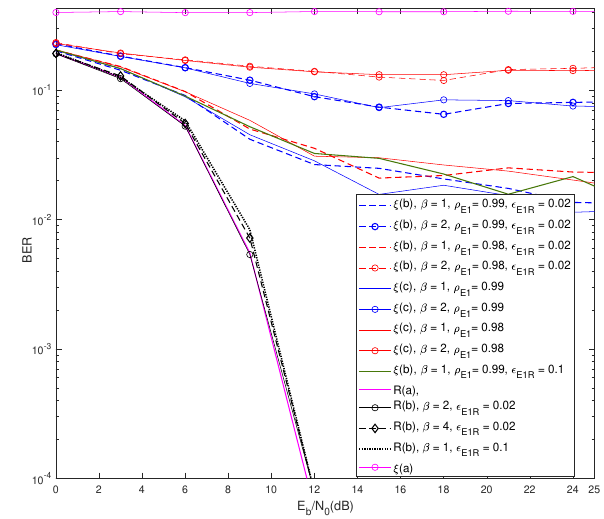
Figure 4. BER performance of ξ in all the scenarios with e E 1 R = 0.02 in scenario B .